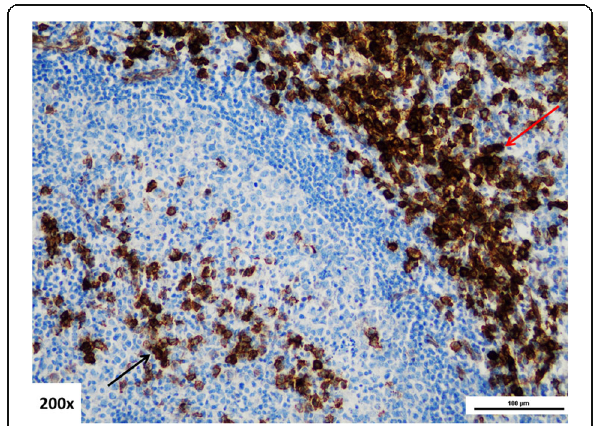
Fig. 3 (CD138 immunostain): Highlights intrafollicular (black arrow) and perifollicular plasma cells (red arrow)